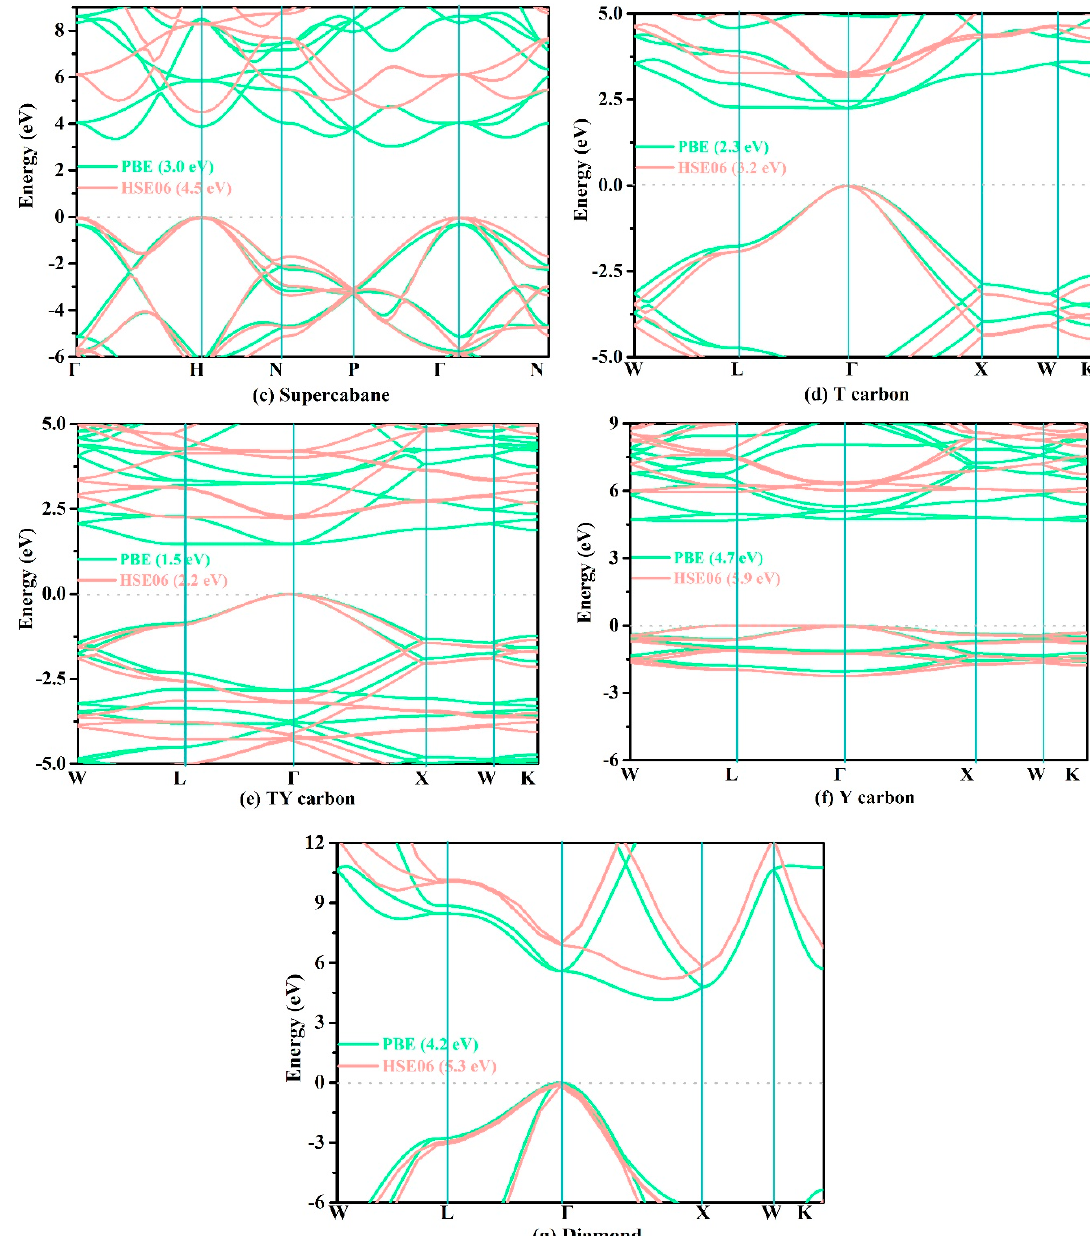
Figure 7. The calculated band structures of cubane-diyne ( a ), cubane-yne ( b ), supercubane ( c ), T carbon ( d ), TY carbon ( e ), Y carbon ( f ), and diamond ( g ), respectively.